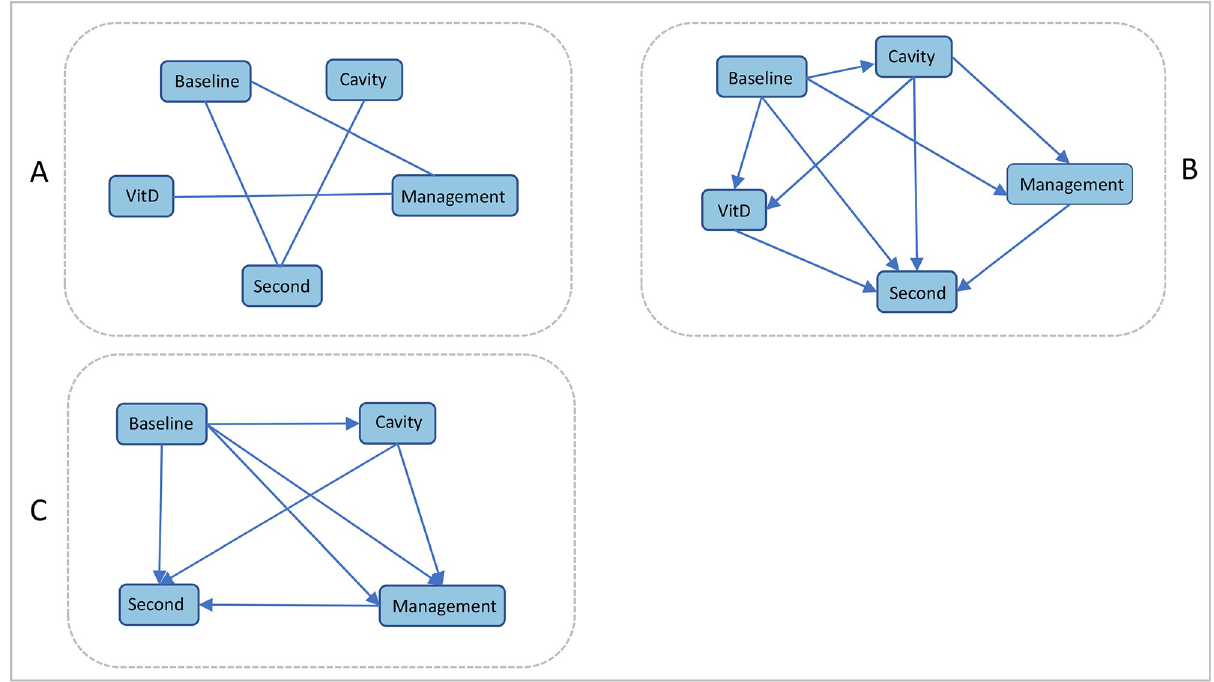
Fig 3. Bayesian network model for second AFB smear-positive in TB patients. A : Initial network structure. B : Bayesian network structure after adding constraints according to prior knowledge. C : Trimmed Bayesian network structure.